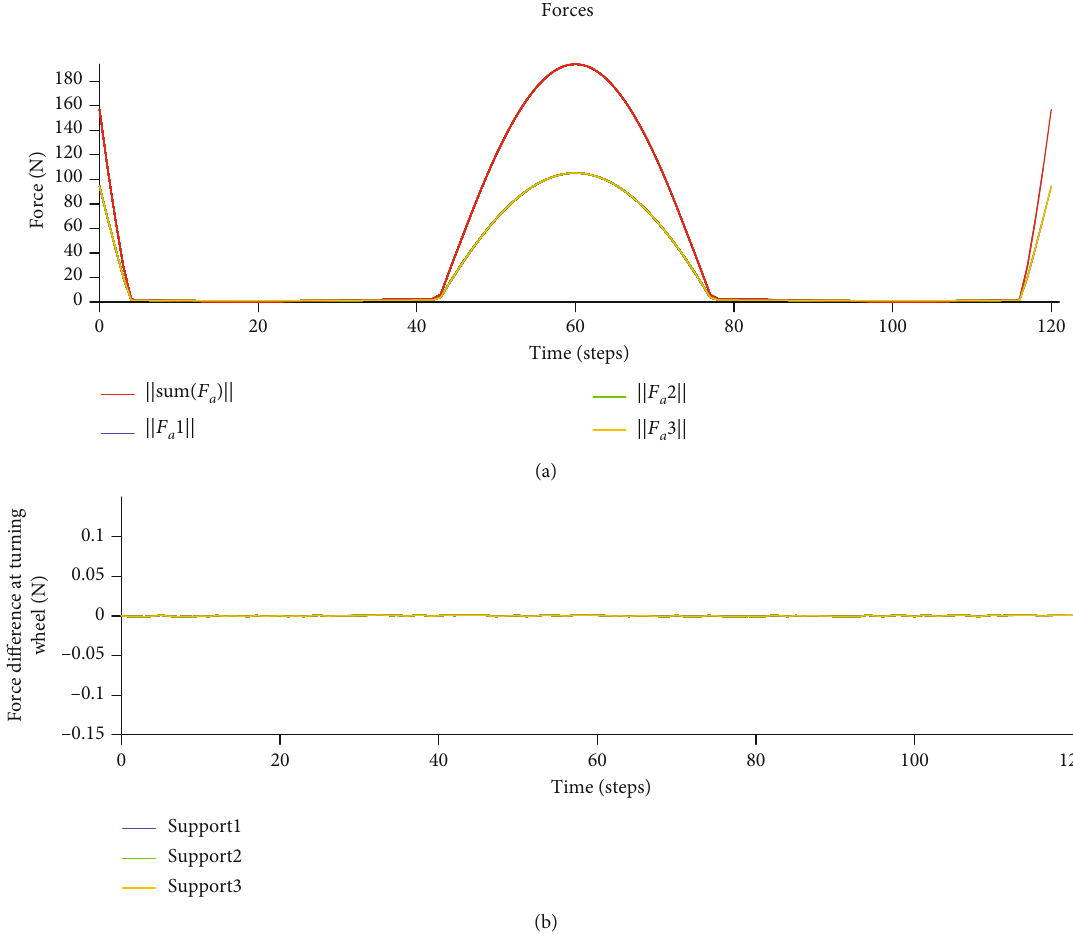
Figure 11: Forces obtained for the trajectory 1. (a) Sum of forces at the lander (in red) and the corresponding individual forces (in blue, green, and yellow), over the time steps of the lander ’ s movement. (b) Virtual forces and their di ff erence (in blue, green, and yellow) for each